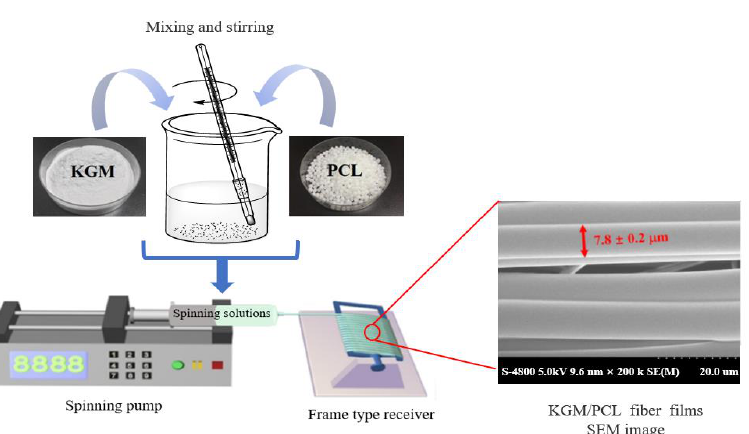
Figure 2. The formation process of producing KGM/poly(caprolactone) fiber films via microfluidic spinning (Adopted from Lin et al., Ni et al. and Lin et al.) [84–86]. Syringe pump speed of 0.5 mL/h, frame receiver speed = 400 arc/min and frequency of the horizontal stepping process = 25 Hz. KGM/ poly(caprolactone)(PLC) and PLC/Ag nanoparticle fibrous films were prepared under the same op- erating conditions.